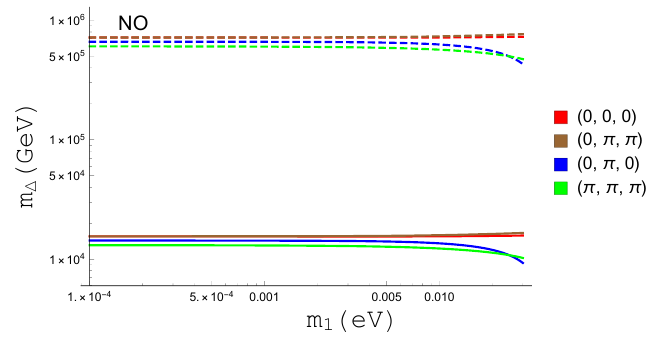
Figure 4 . Comparison plot of the maximum m ∆ probed by µ to e conversion in Ti nuclei tests at the SINDRUM experiment [103] (Dashed) and at the upcoming COMET experiment [26] (Solid) for different sets of neutrino CP phases ( δ CP , α 21 , α 31 ) and varying lightest neutrino mass, in the NO scenario. All other parameters are given by the best fit parameters in table